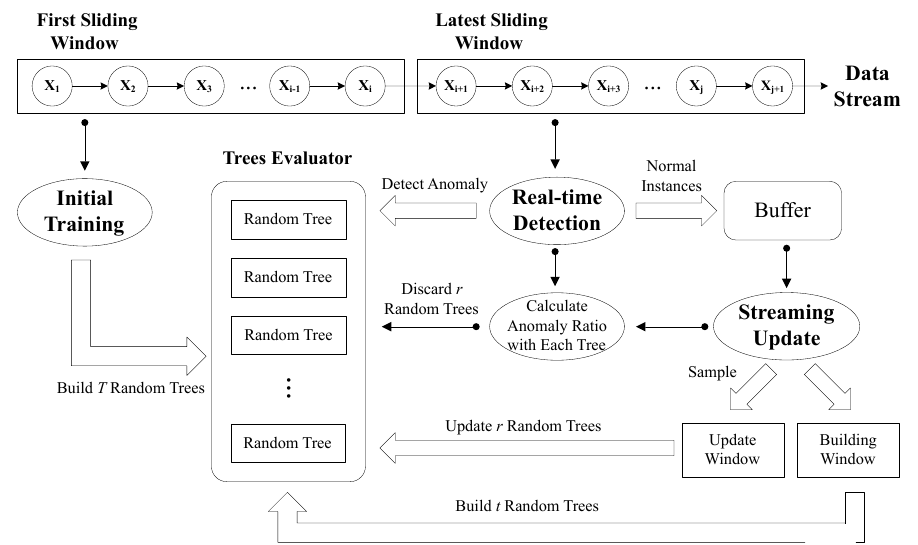
Figure 1. The workflow of unsupervised incremental anomaly